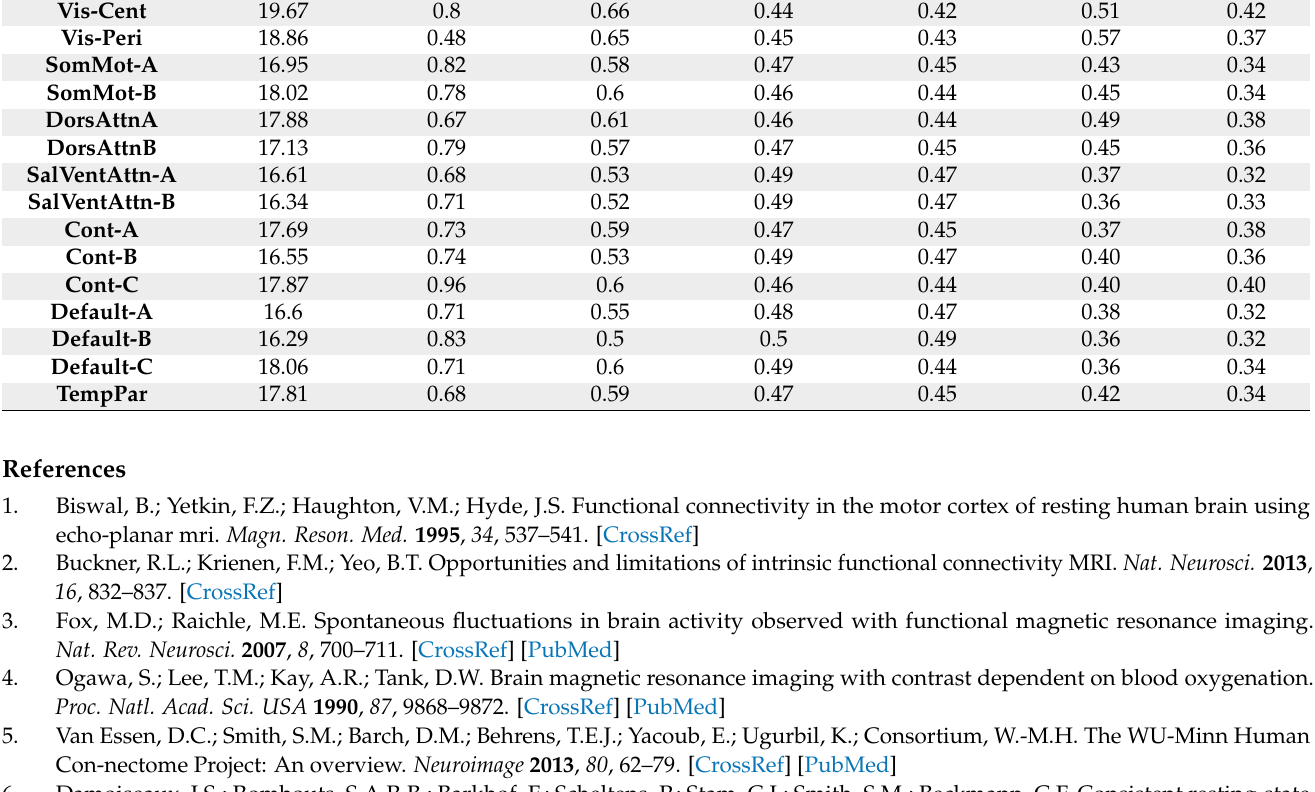
Figure A5. Statistical sufficiency of the sample size. To demonstrate the statistical sufficiency of our sample size (N = 183), we ran an analysis similar to that presented in Figures 3 and 4 of the main text using a smaller sample size (N = 100). Results presented in Figure A5 show practically the same correlations with only slightly smaller R 2 values.